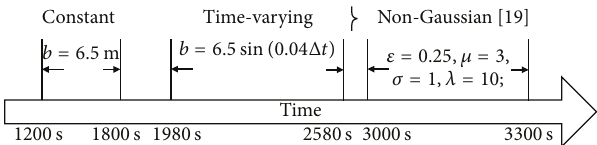
Figure 2: GPS attack timing sequence.